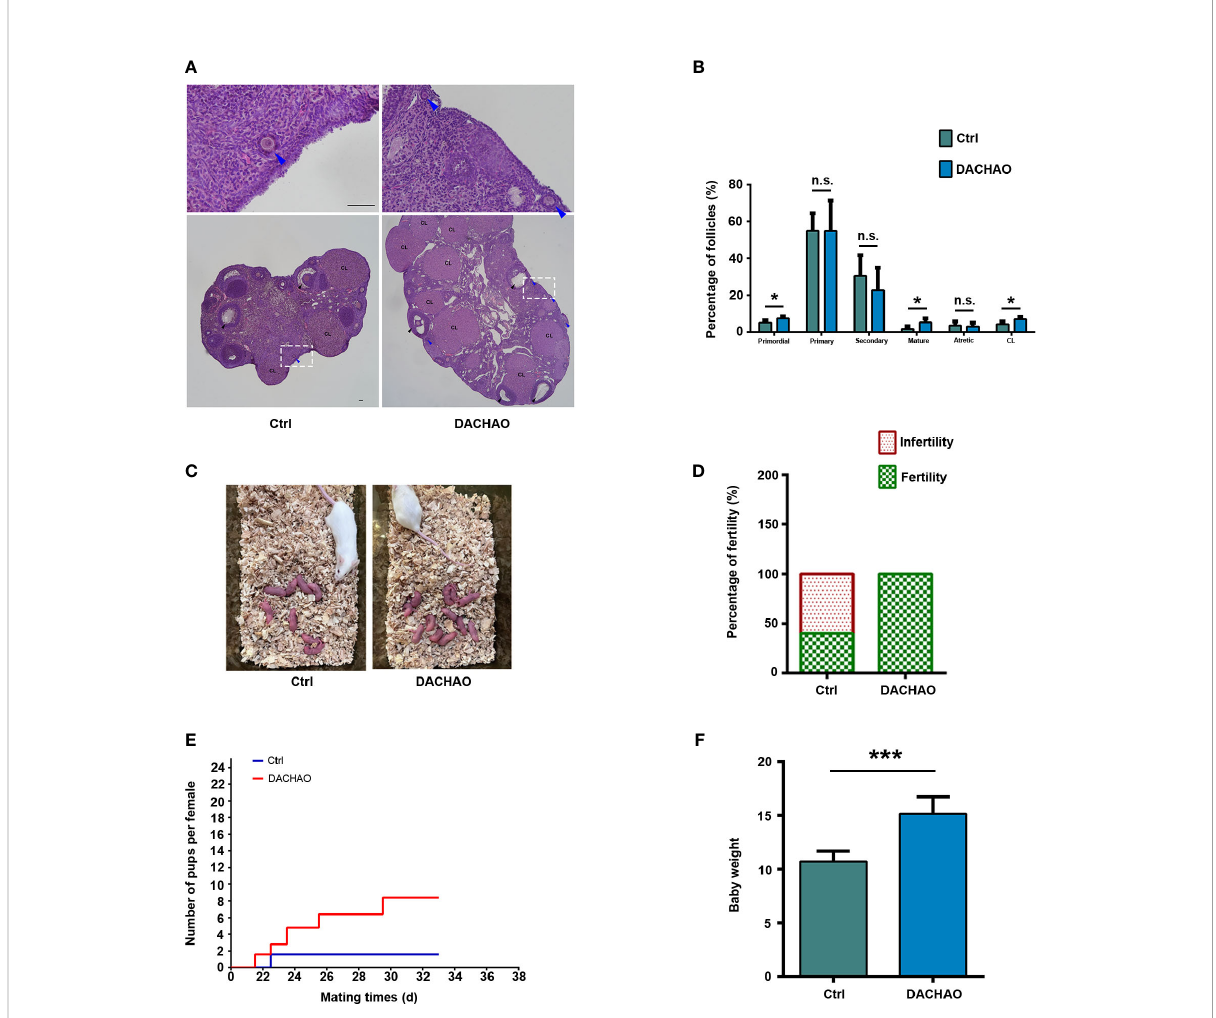
FIGURE 4 The improvement of DACHAO treatment on fertility in aged mice. (A) HE staining of mouse ovarian sections in each group. (B) Statistical graph representing the percentage of follicles at different stages in the ovaries from aged female mice in each group. (n=4/group). (C) Litters of aged female mice in each group after co-mating. (D) Statistical graph of pregnancy percentage in each group of aged female mice (n=5/group). (E) Fertility curves of aged female mice in each group (n=5/group). (F) Statistical graph of body weight of offspring mice in each group at weaning (n=36). *P < 0.05, ***P < 0.001, and n.s. P ≥ 0.05 compared with the control group. n = the number of mice in each group. All bars =50 m